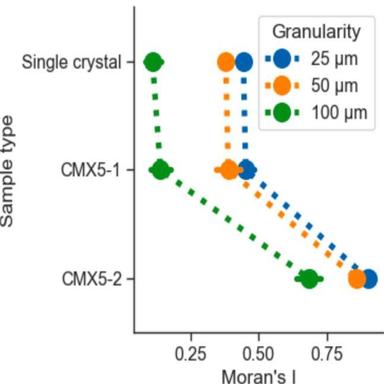
Moran's I value for BAS imaging plate across varying readout granularity readings. Each data point showcases the average and standard deviation of three different images.